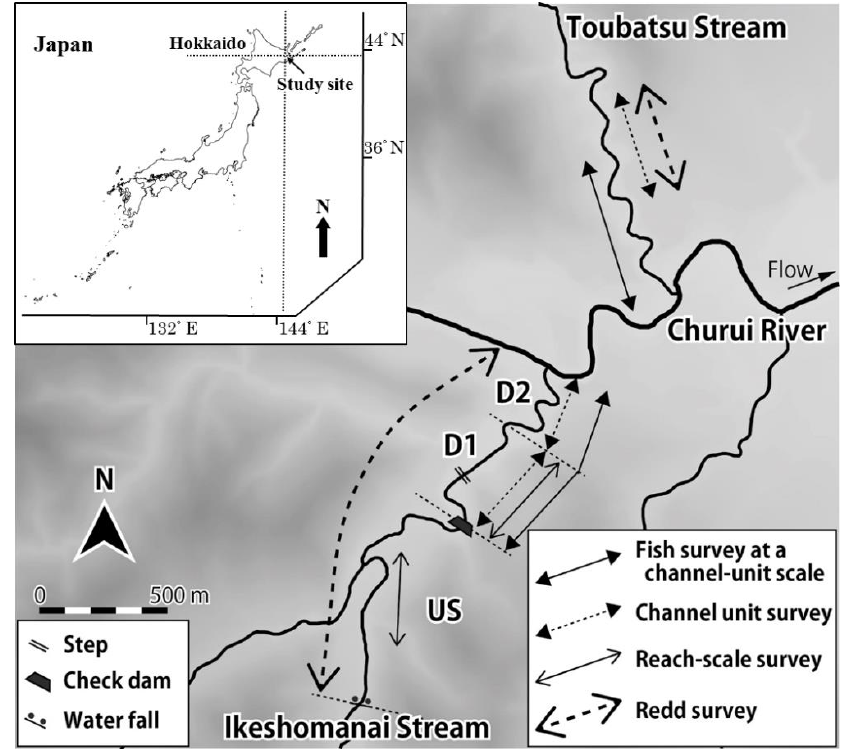
Figure 1. The location of the study streams and allocation of the study sections for the different surveys.